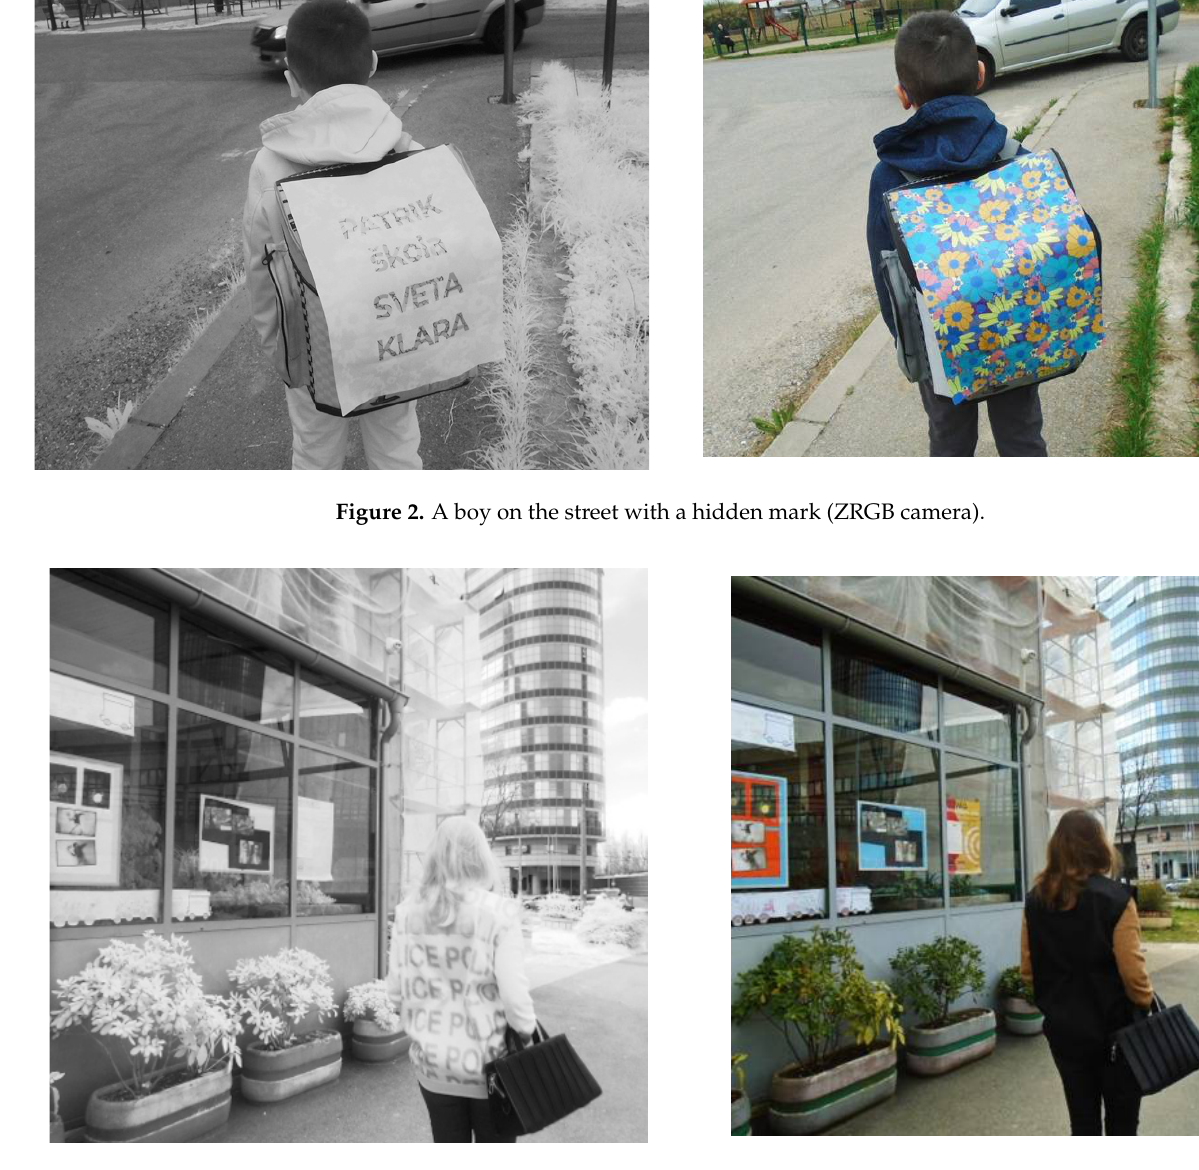
Figure 3. Visit to the school recorded with dual ZRGB cameras.